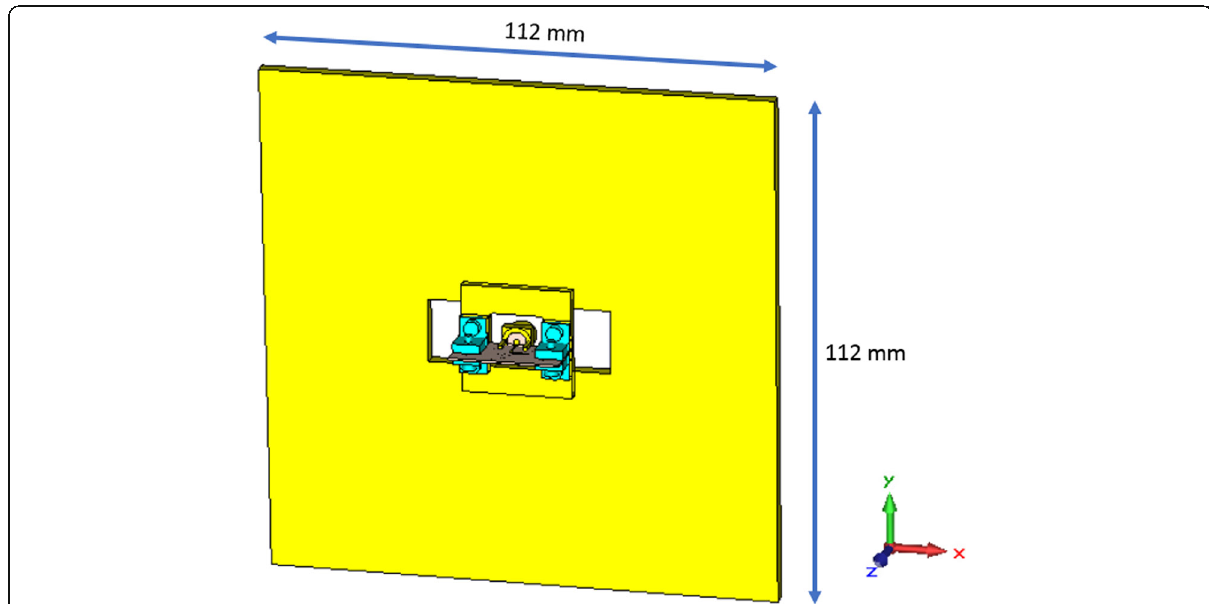
give a comparison of the size. The simulated (blue dashed lines) and measured (red lines) radiation pat- terns for the co-polar component are compared in Figs. 24 and 25 for both principal planes, elevation and azimuth cuts, respectively. A slight asymmetry of the current distributions can be observed that ex- plains the approximately 20° deviation of the max- imum on the elevation cut shown by the red line on Fig. 24 a. An almost symmetric response is obtained in the azimuth cut shown in Fig. 24b. The large size of the supporting plate generates a reflected signal that adds to the prototype radiation causing an in- creased degradation of the measured patterns when departing from boresight (0°). Also, both the roll positioner and mast covered by absorbers block the measured signal on the back side which translates to